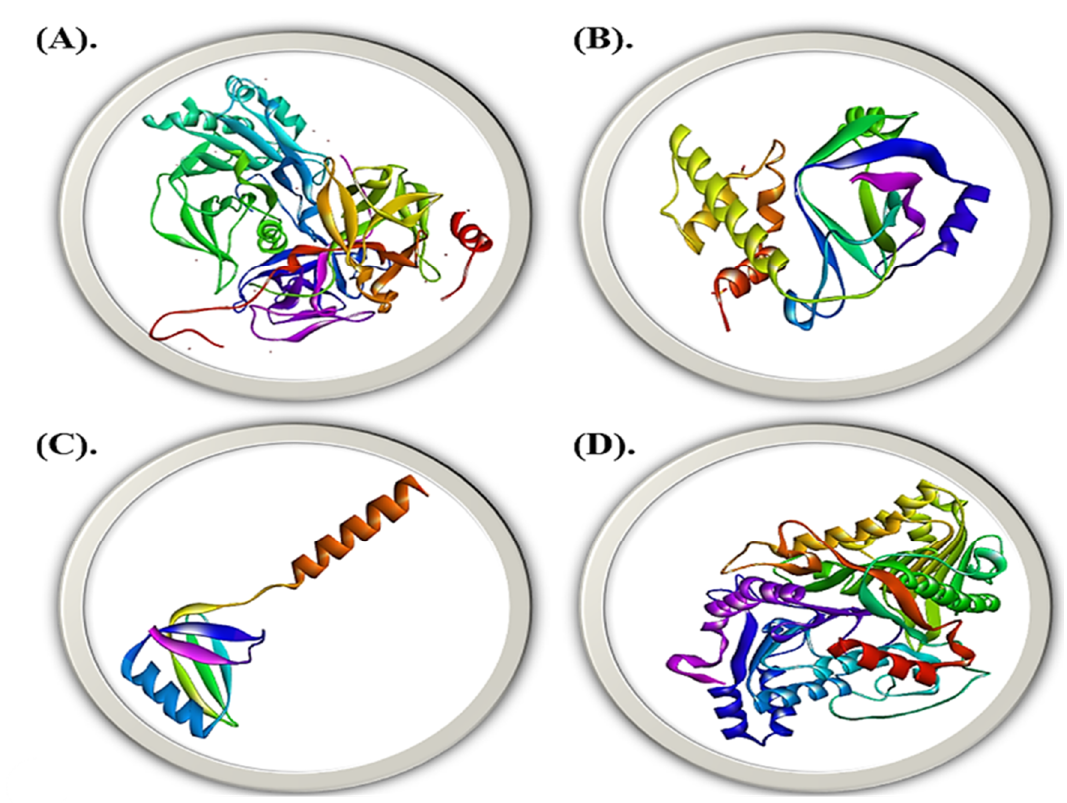
Figure 9. 3-D structure prediction of the virulent genes of gut bacteria via trRossetta. ( A ) cdt, ( B ) spvB, ( C ) stxB, and ( D ) ymt.